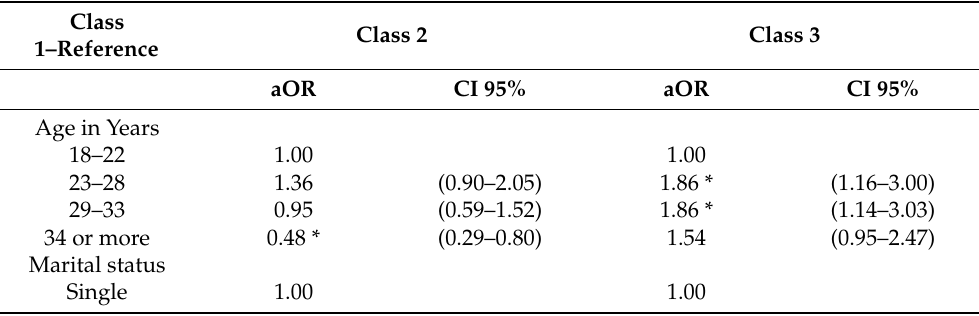
Table 3. Multinomial logistic regression predicting class membership relative to Class 1 of 1760 MSM visiting HIV clinics in Mexico City, 2018–2019.